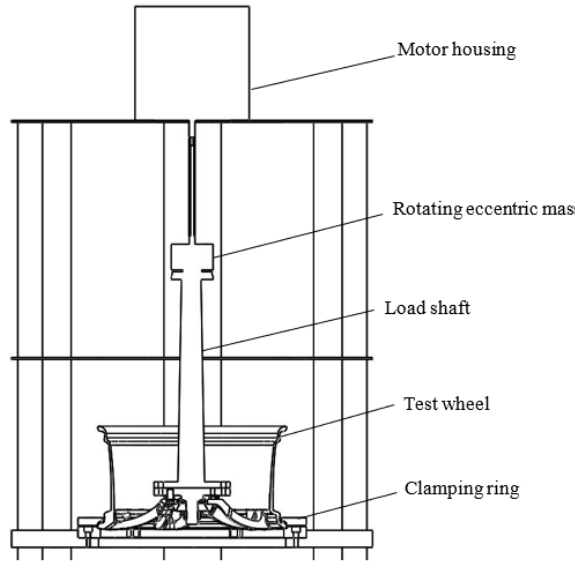
Figure 1: Schematic of the dynamic cornering fatigue test